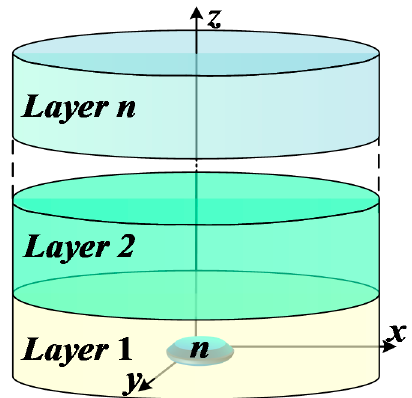
Figure 3. 3D layered model with a node 𝑛 located at the origin of the coordinate system.